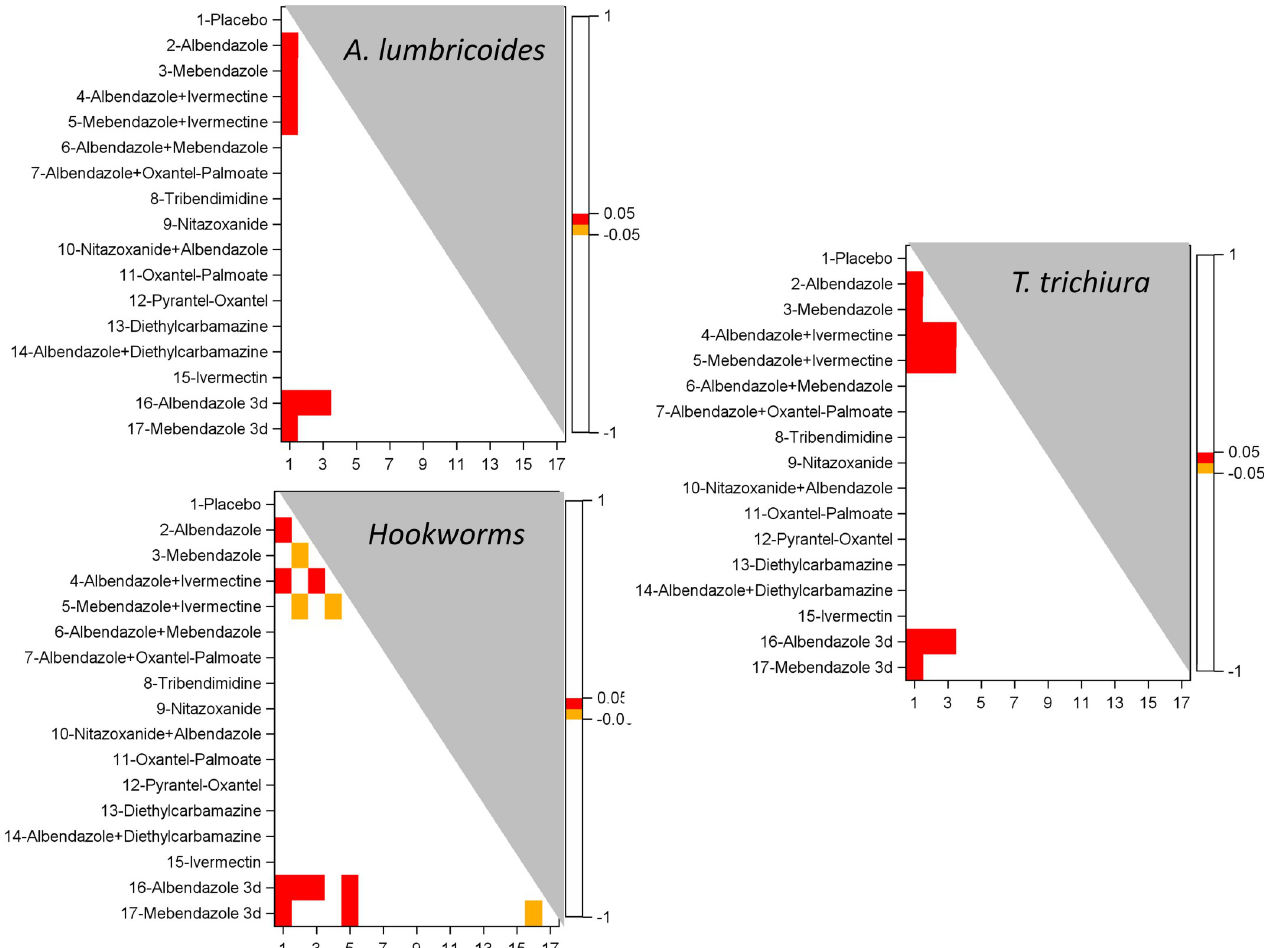
Fig 15. Heatmaps of the results of post-hoc multiplicity adjusted tests following a linear mixed model of the EPG at post treatment in studies of 22–45 days follow-up: A. A . lumbricoides , B. T . trichiura , C. hookworm.